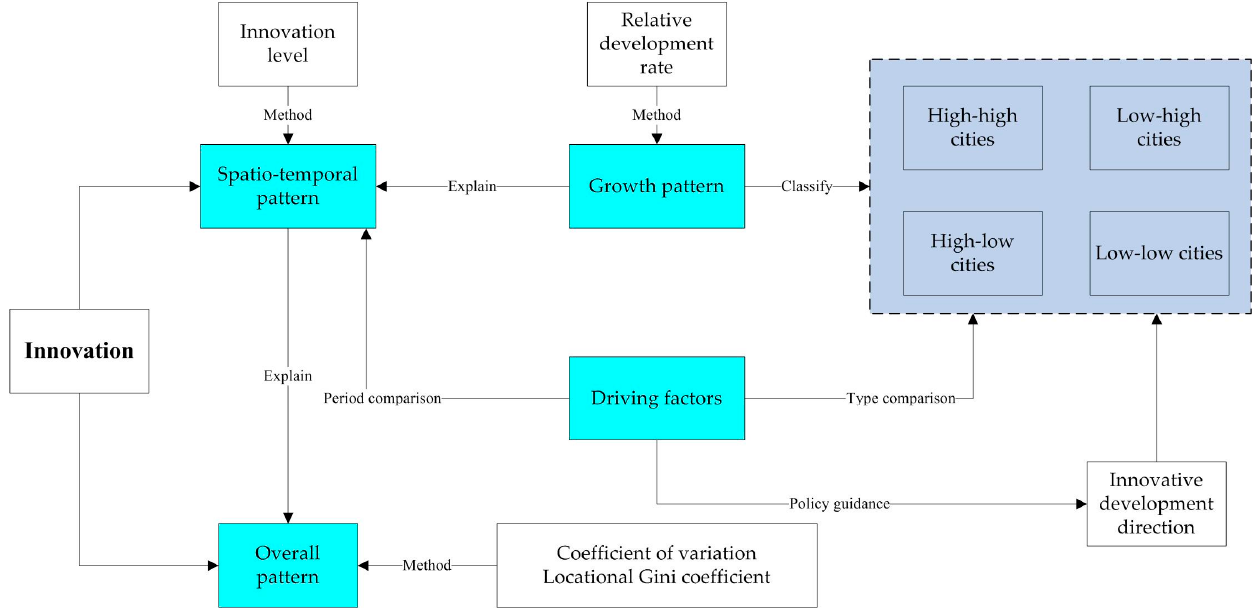
Figure 1. The basic research